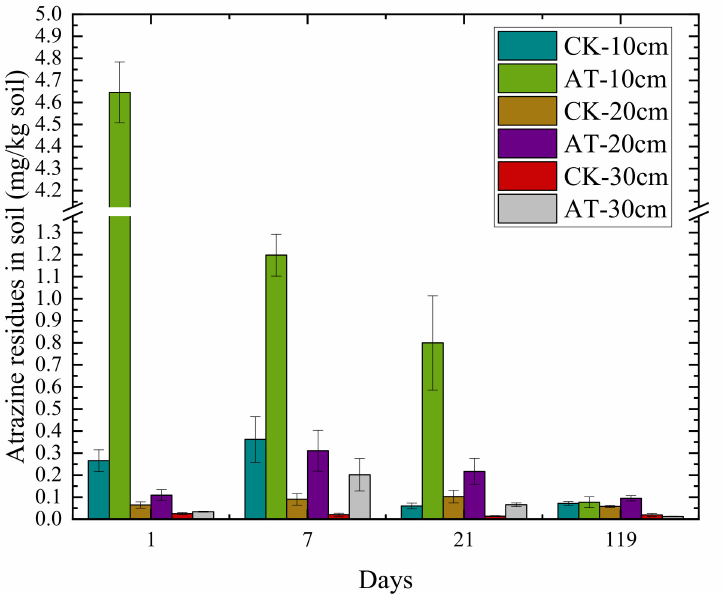
Figure 1. Changes in atrazine residue in various soil layers at different periods after application. Each value represents mean ± SD ( n =